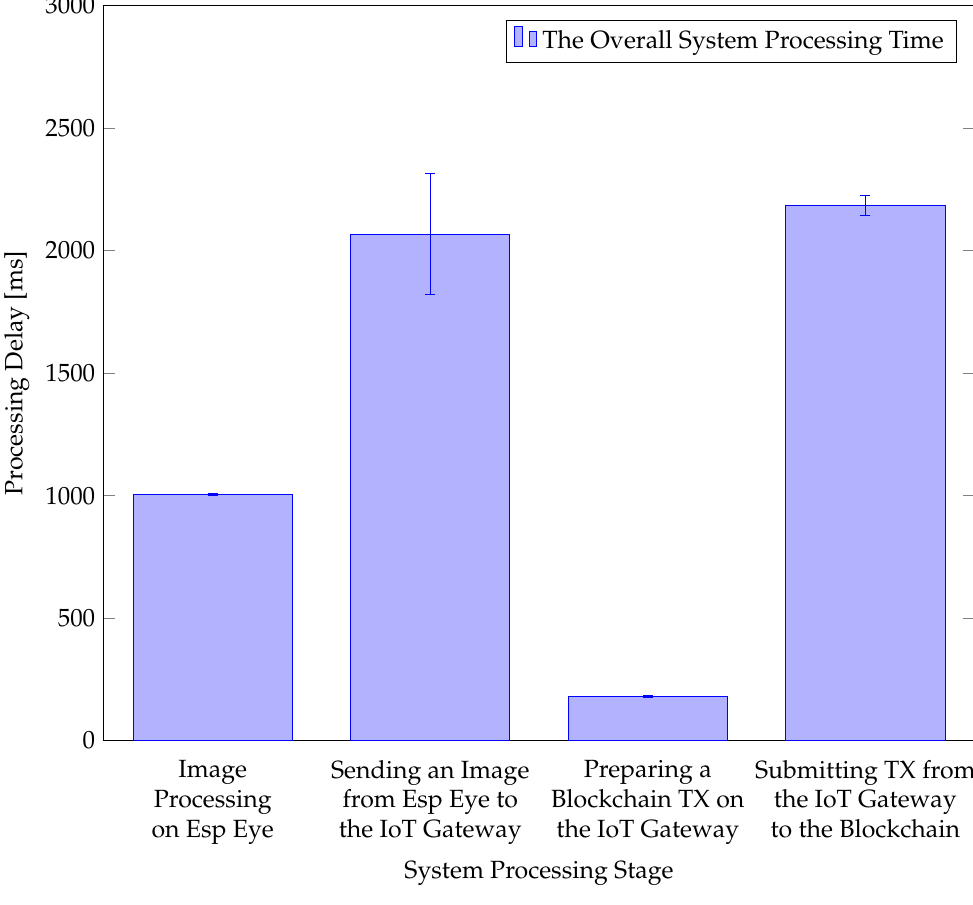
Figure 9. System Processing